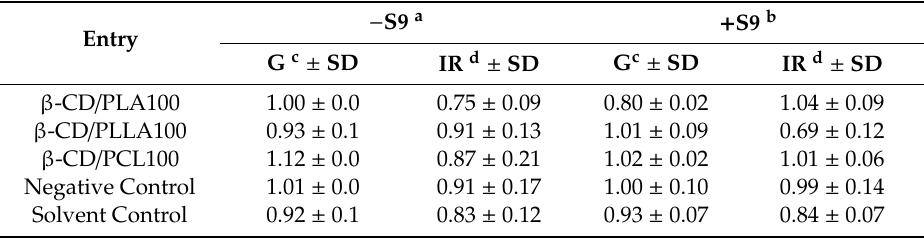
Table 4. The results of the umu-test for the highest concentrations of the tested extracts (0.66 mg / mL). Entry